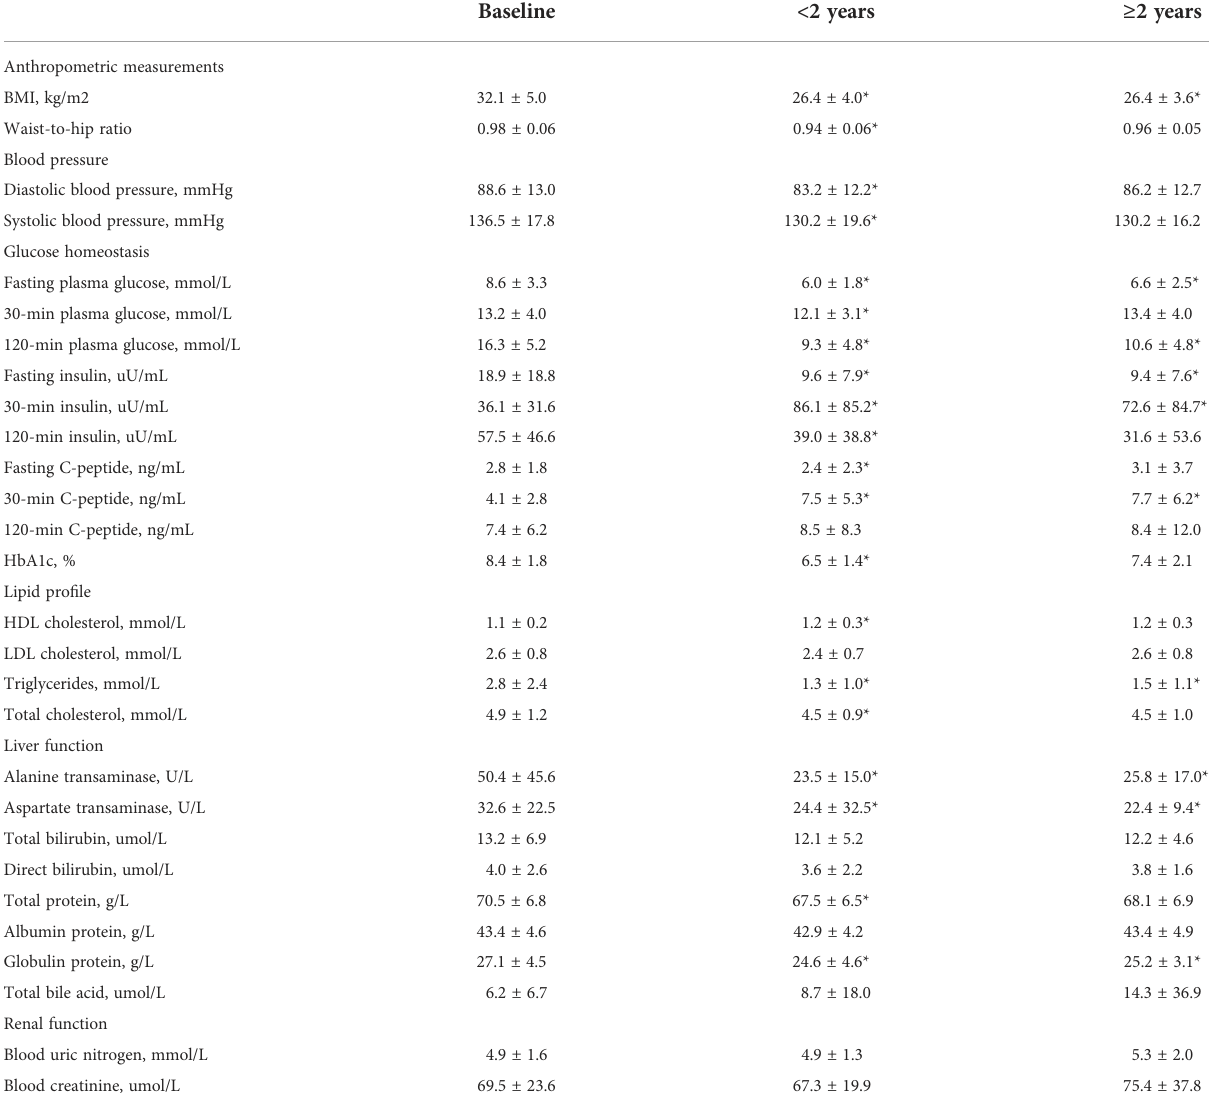
TABLE 2 Variables in the preoperative and postoperative periods.